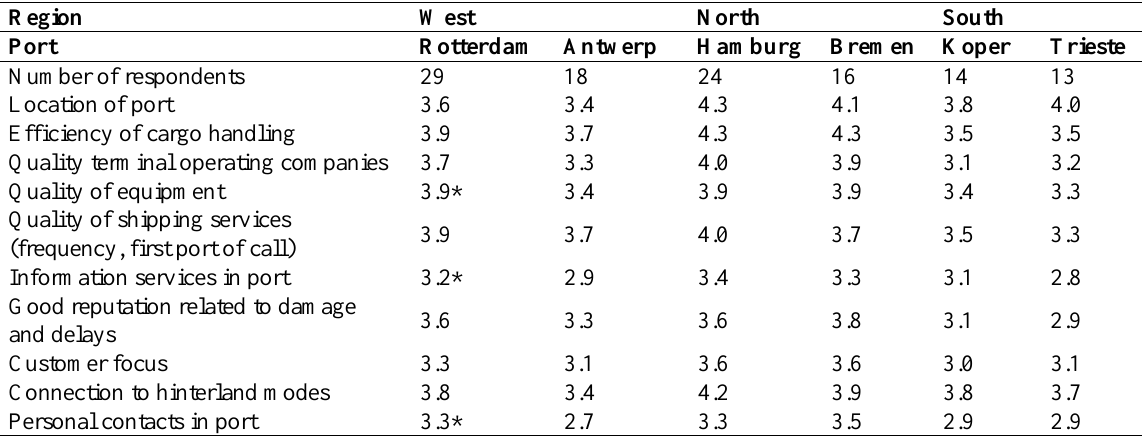
Table 6. Scores of six ports competing for Austrian cargo